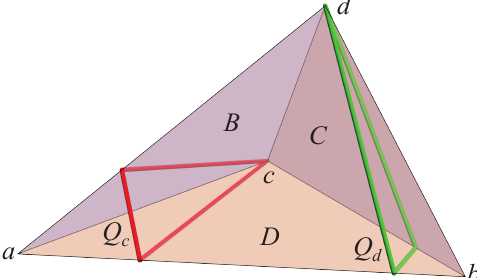
Figure 6. Case 2.2.2: Q c and Q d on the 3D tetrahedron unfolded in Figure 5. Q c is a quasigeodesic. Case